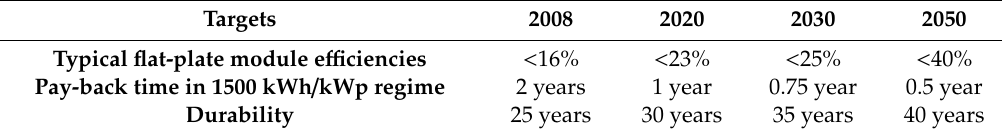
Table 4. General technology target (Source: Technology Roadmap, solar photovoltaic energy, IEA